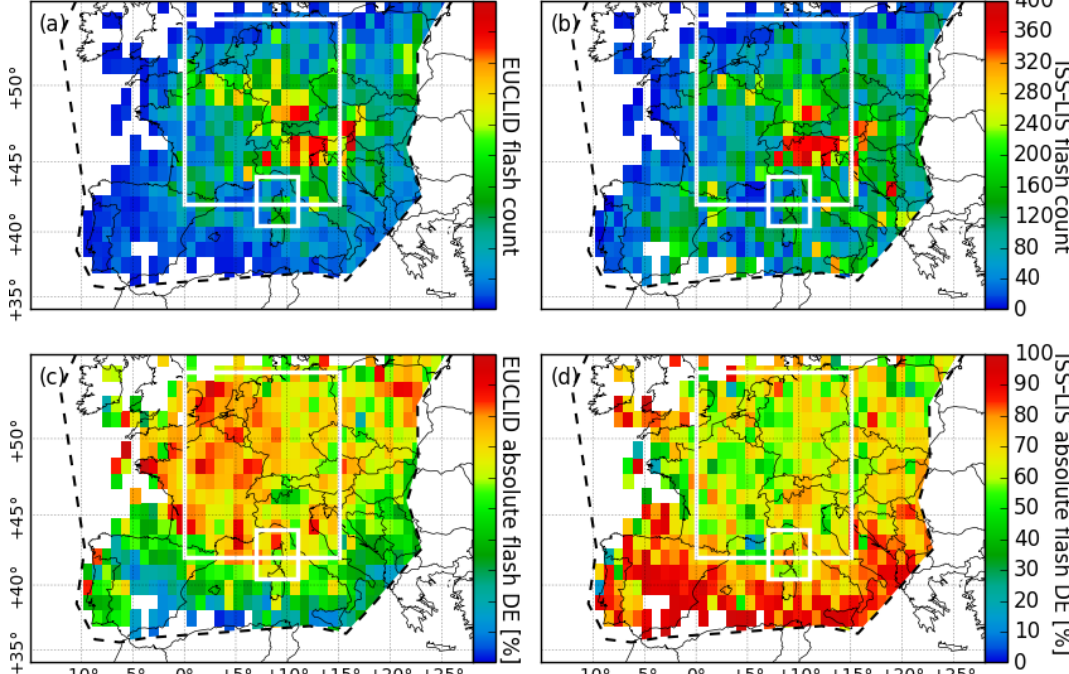
Figure 7. EUCLID and ISS-LIS flash counts are depicted in (a) and (b) , respectively. Plots (c) and (d) show the spatial distribution of the EUCLID and ISS-LIS absolute detection efficiencies, respectively. The large rectangle highlighted in white is the self-defined center of the EUCLID network in Fig. 3, whereas the smaller white rectangle highlights the area used in Erdmann et al. (2020) against which the results in this paper are compared